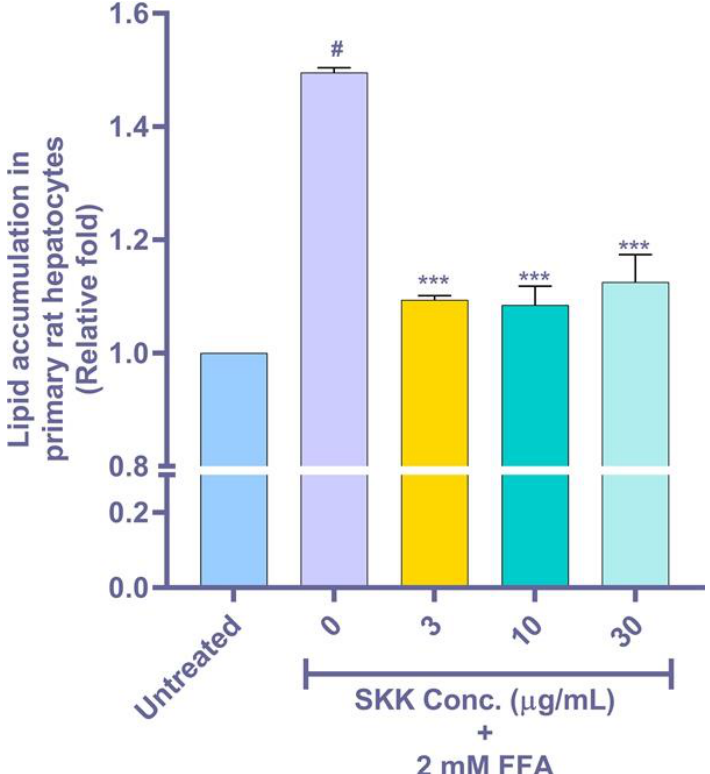
Figure 6. Lipid accumulation and its amelioration by SKK in primary rat hepatocytes. Steatosis induction was evaluated using isolated rat hepatocytes after induction with 2 mM FFA mixture and treatment with SKK (0, 3, 10 and 30 µg/mL) for 12 hrs. Results are displayed as mean ± SEM. The experiment was performed thrice in duplicate. For statistical analysis, one-way ANOVA with Dunnett’s multiple comparisons was performed, where untreated control vs. 0 μg/mL= # p value < 0.001 and SKK test concentrations vs. 0 μg/mL= *** p value < 0.001.